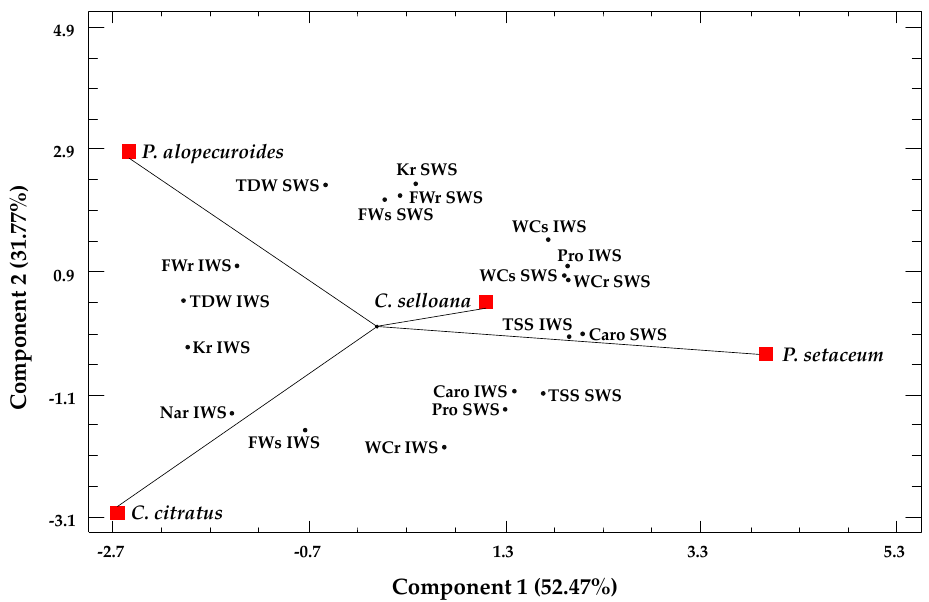
Figure 8. Principal Component Analysis of growth and biochemical data of C. citratus , C. selloana , P. alopecuroides and P. setaceum . Loading and scatter plots of the PCA scores were conducted only with the parameters that showed a significant correlation. Abbreviations: IWS, intermediate water stress; SWS, severe water stress; TDW, total dry weight; FWr, root fresh weight root; FWs, shoot fresh weight; WCr, root water content; WCs, shoot water content; Caro, carotenoids; Pro, proline; TSS, total soluble sugars; Kr, root potassium content; Nar, root sodium content.